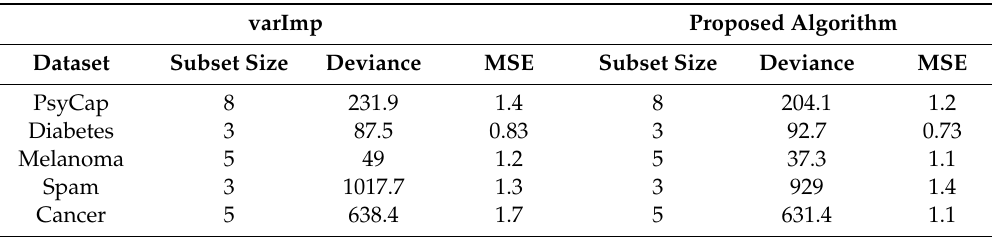
Table 4. Goodness of fit evaluation according to varlmp and the proposed